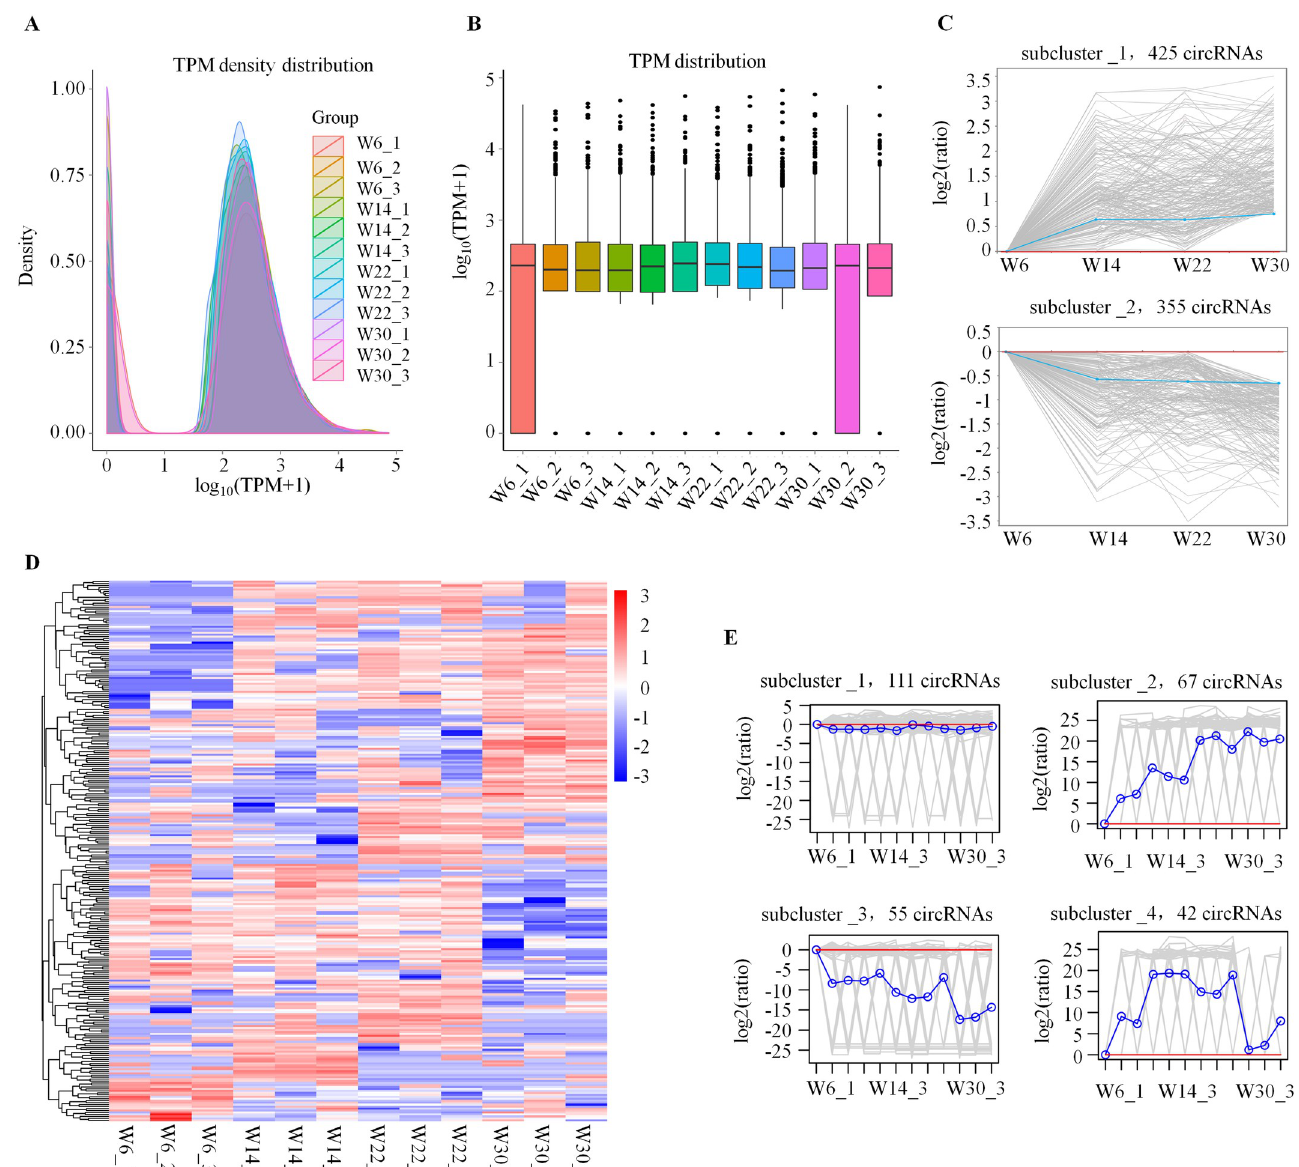
Fig 2. Expression analysis of circRNAs during the development of abdominal fat in Gushi chickens. (A) Density distribution of TPM values of circRNAs in each library. (B) Box plot of TPM values of circRNAs in 12 libraries. (C) Two subclusters of the circRNA expression profile in Gushi chicken abdominal adipose tissue. K-means clustering was used to represent the circRNA dynamic profile. The gray line is a line chart representing the relative expression level of a given circRNA for the four developmental stages. The blue line is a line chart representing the relative mean expression level of all circRNAs for the four developmental stages. The red line is for reference; circRNAs above the red line were upregulated, and those below the red line were downregulated. (D) Hierarchical clustering of the DE circRNAs in 12 libraries. (E) K-means cluster map of the DE circRNAs.